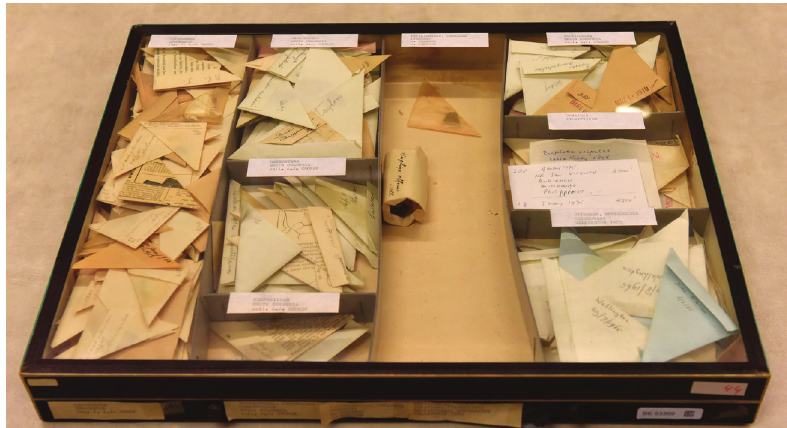
Figure 2. An old drawer filled with papered Lepidoptera. The drawer contains rough information (on stickers) about locality and collector, while the individual envelopes have more specific information on locality and date written on them. Photo by Luisa de